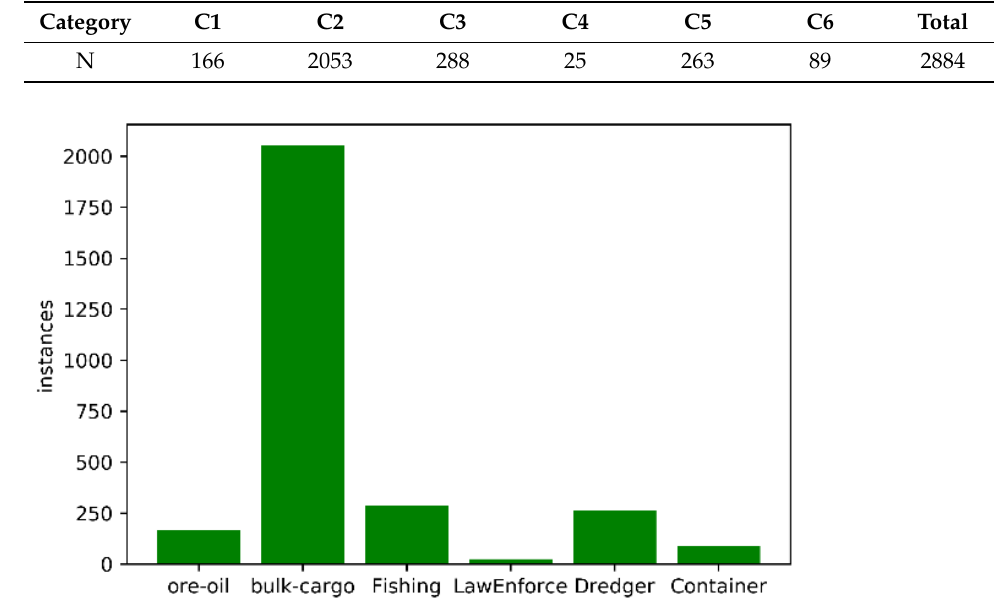
Table 2. Statistics of the number of vessels of each type.